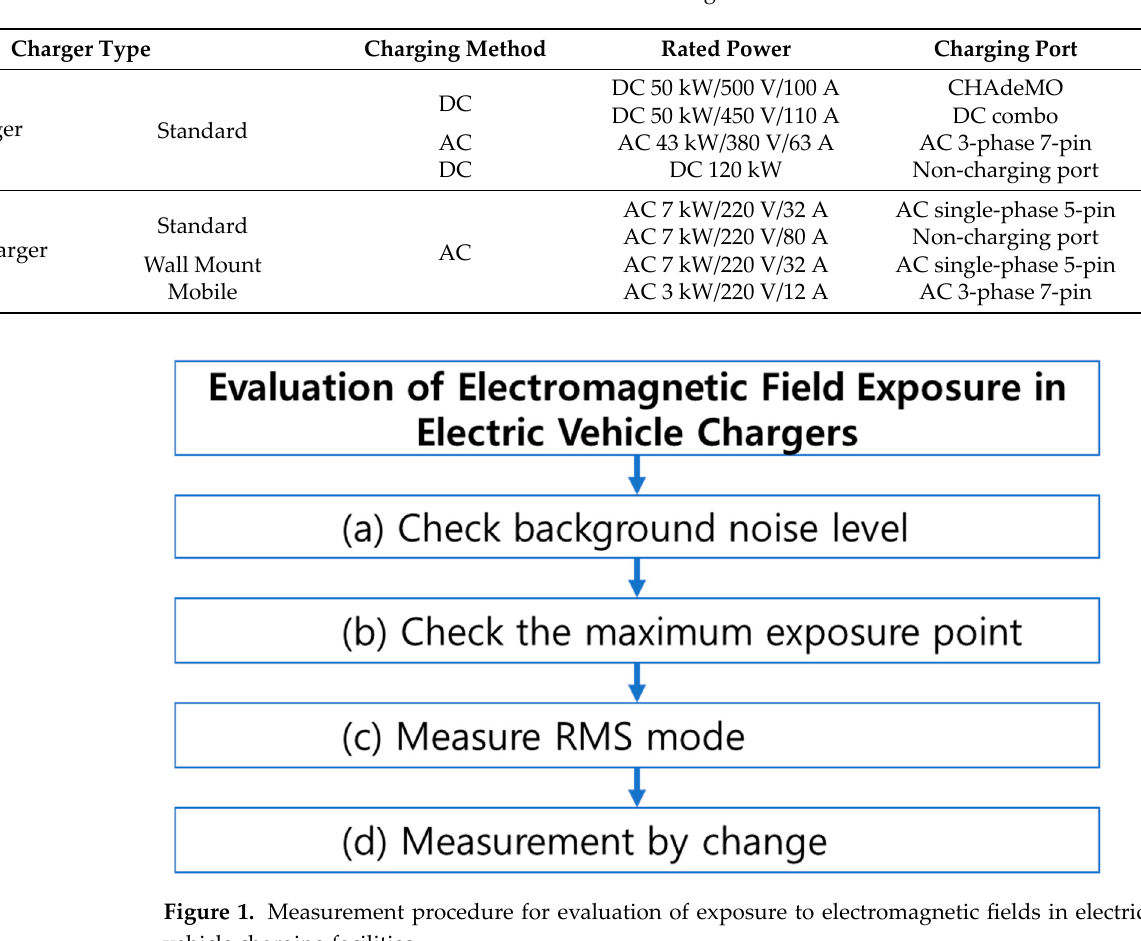
Table 2. Classification of domestic electric vehicle chargers.